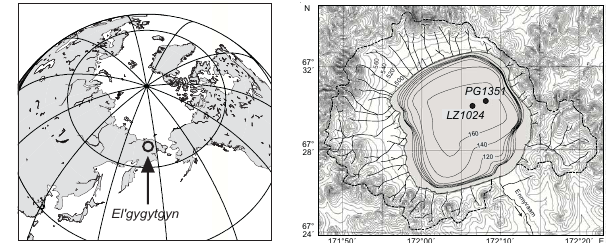
Fig. 1. Location of Lake El’gygytgyn (circle, not to scale) on the Chukotka peninsula, Far East Russian Arctic (left) and close up of the lake with the watershed (dashed line, contour interval for topog- raphy is 20m) and the locations of the sediment cores investigated